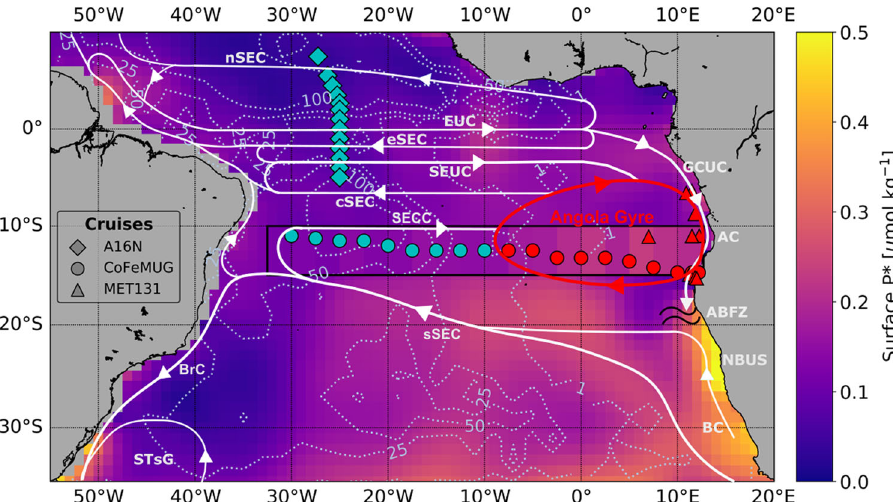
Fig. 1 Surface P* across the South Atlantic Ocean. Station locations (coloured symbols) overlaid on an annual climatology of the South Atlantic surface P* concentration ( = [PO 4 3 − ] – [NO 3 − ]/15.5; SI.1). As indicated in the legend, circles represent stations sampled during the CoFeMUG cruise in November/ December 2007 14,34 , triangles show stations sampled during the MET131 cruise in October 2016, and diamonds indicate stations sampled during the CLIVAR/GO-SHIP A16N cruise in September/October 2013 14,49 . Red symbols show Angola Gyre stations and blue symbols represent western basin stations. The red cell indicates the approximate position of the Angola Gyre, and the white arrows show the circulation of thermocline waters in the tropical South Atlantic Ocean. The black box encloses P* values calculated from the CoFeMUG data set, while the other P* data are from WOA18 8 (SI.1). The dotted light-grey contours show the distribution of recent modelled water column-integrated N 2 fi xation rates for the South Atlantic(1, 25, 50 and 100 mmolN.m − 2 .a − 1 ) 13 . The South Atlantic Tropical Gyre is de fi ned by the sSEC, SEUC and AC, where sSEC is south South Equatorial Current, SEUC is South Equatorial Undercurrent, and AC is Angola Current. Additionally, nSEC is north South Equatorial Current, EUC is Equatorial Undercurrent, eSEC is equatorial South Equatorial Current, cSEC is central South Equatorial Current, SECC is South Equatorial Countercurrent, GCUC is Gabon-Congo Undercurrent, ABFZ is Angola-Benguela Frontal Zone (indicated by the parallel wavy lines), NBUS is northern Benguela upwelling system, BC is Benguela Current, BrC is Brazil Current, and STsG is Subtropical